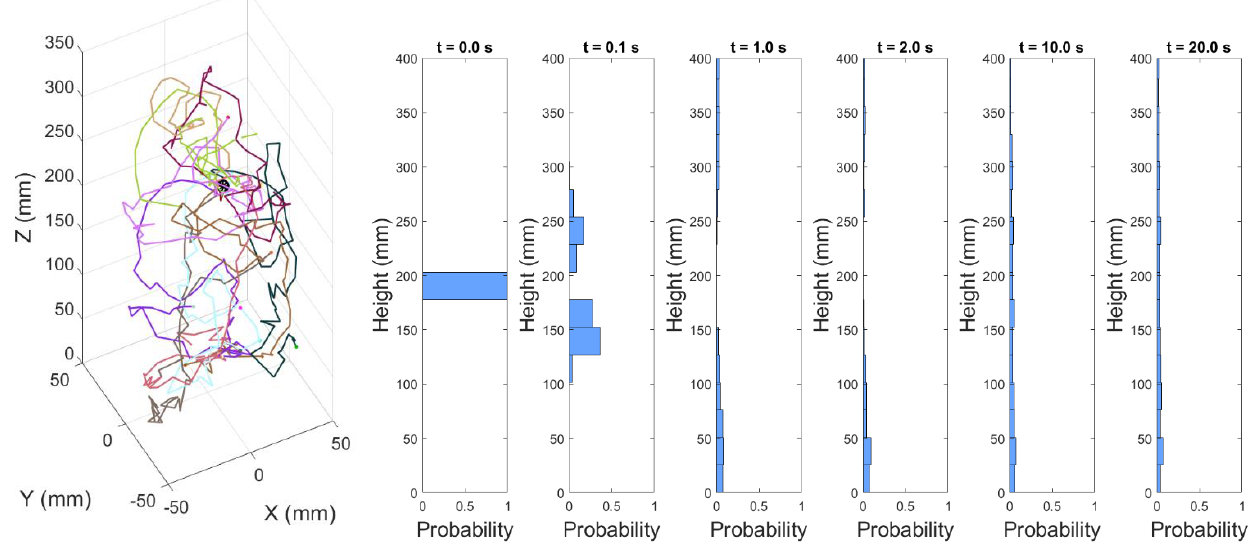
Figure 3. Manifold of three-dimensional trajectories within the GLSFB ( left ) and histograms ( right ) corresponding to the axial position at different times: 0; 0.1; 1; 2; 10, and 20 s. Number of bins: 30.